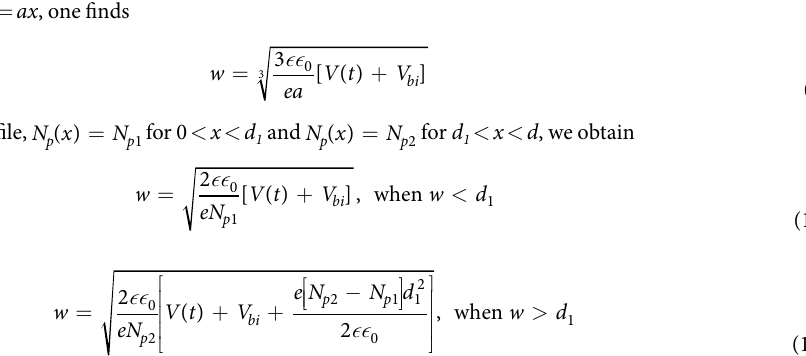
Figure 2. ( a ) Simulated doping-CELIV current transients, plotted as ( j/j 0 ) − 2 vs applied transient voltage, for V OFF = 0, are depicted by the solid colored lines. The analytical approximations of = − j j w d ( / ) / = p x N x ( ) ( ) (Eq. (12) and Eq. (13)) are indicated by dashed lines. ( b ) The same current transients as in a), but p plotted as ( j/j 0 ) − 3 instead. ( c ) The carrier density profiles, as extracted from the simulated CELIV current transients in a), using Eq. (11) and Eq. (10) (to obtain p ( w ) and w , respectively), are depicted by the colored lines. The corresponding densities of ionized dopants, N p ( x ), are depicted by the dashed, short-dashed, and dotted lines for uniform, linear and step profiles,